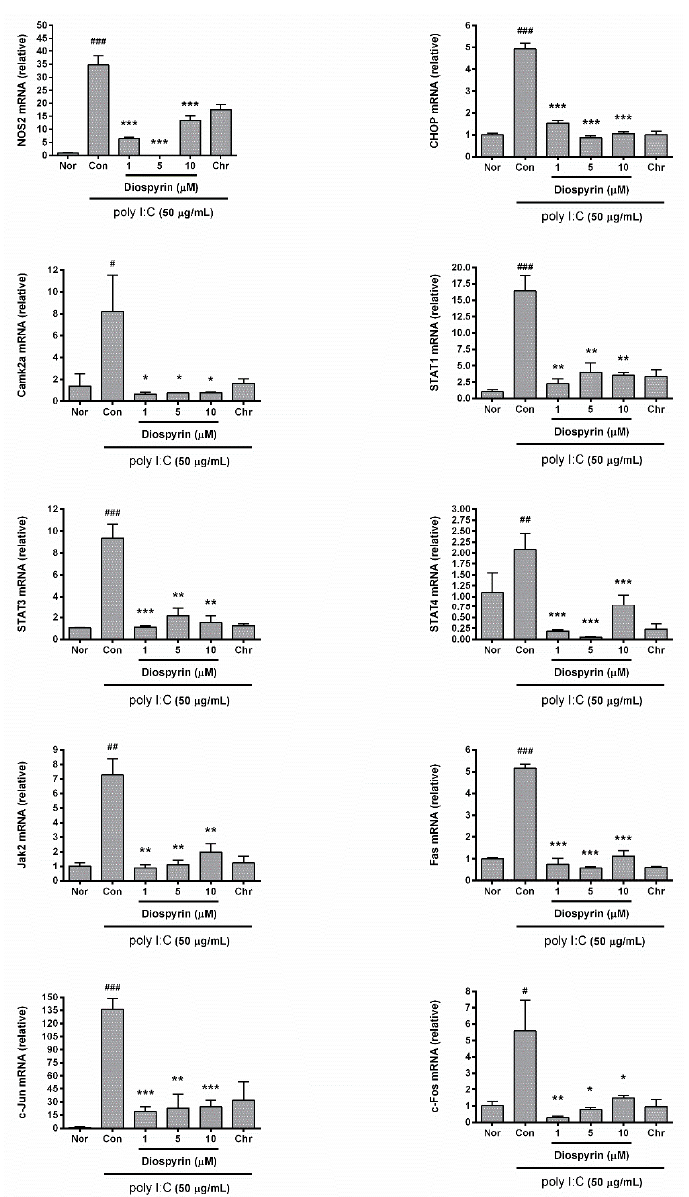
Figure 4. Expressions of NOS2 , CHOP , Camk2a , STAT1 , STAT3 , STAT4, Jak2 , Fas, c-Jun, and c-Fos mRNA in RAW 264.7. mRNA expressions were normalized to β -actin . Values are the mean ± SD of the three independent experiments. Nor, media alone; Chr, Chrysin (10 µ M). # p < 0.05 vs. Nor; ## p < 0.01 vs. Nor; ### p < 0.001 vs. Nor; * p < 0.05 vs. Con; ** p < 0.01 vs. Con; *** p < 0.001 vs. Con.